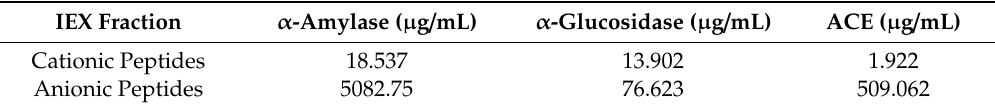
IC 50: The peptide concentration required to inhibit 50% of enzyme activity. CPHD = cricket protein hydrolysates after simulated digestion with gastrointestinal enzymes. NF- κ B Expression in Macrophage (RAW 264.7) Cells